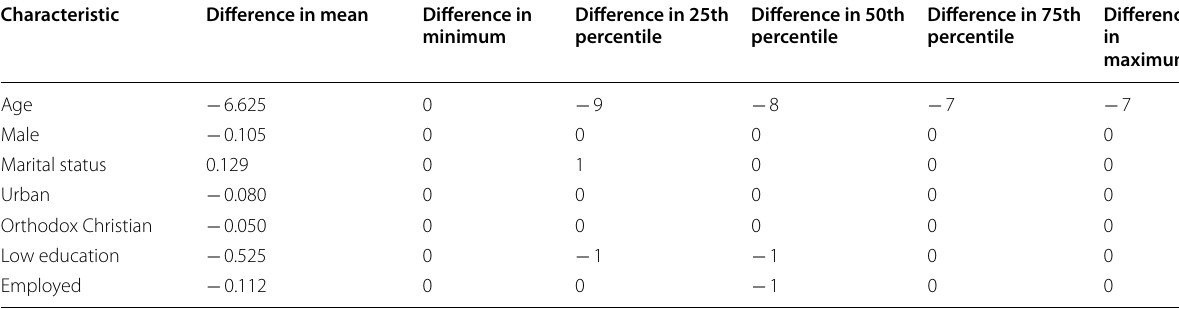
Overall L1 statistic